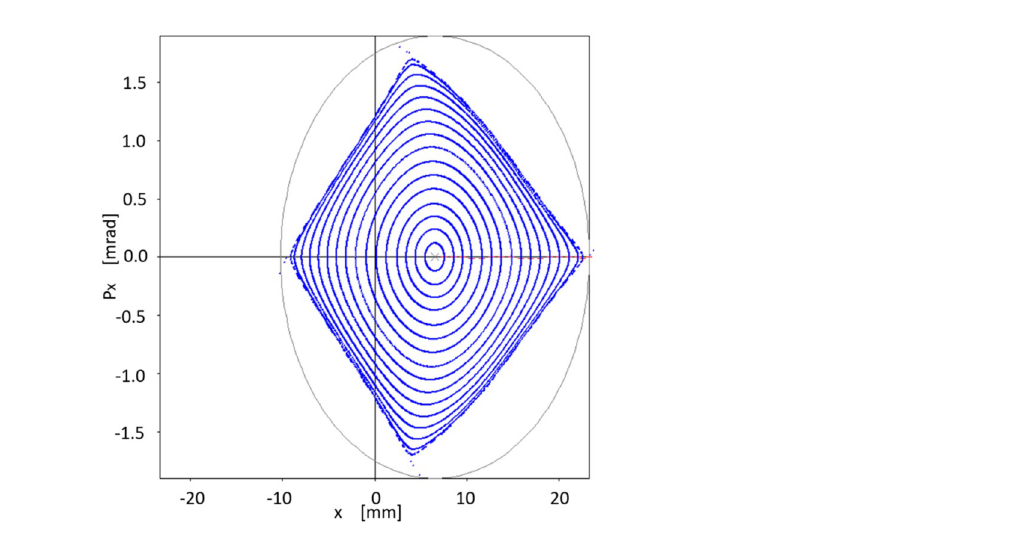
Figure 17. Structure of phase space ( x , p x ) for δ = 3% when various initial conditions are used for particle tracking simulation in OPA, using the set of sextupoles { S 2 }